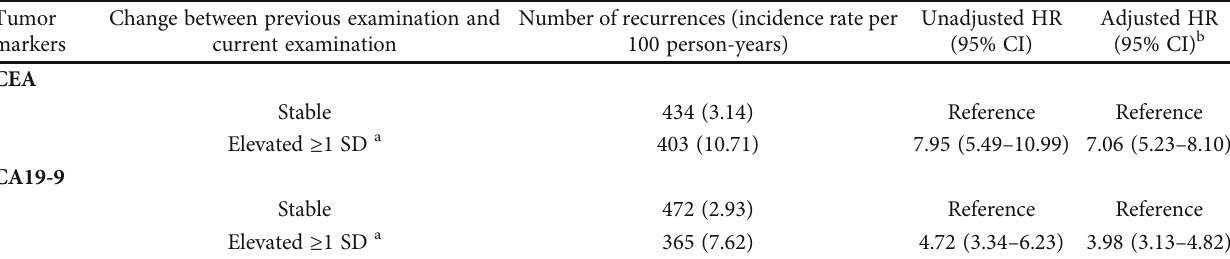
Table 2: HR for recurrence based on changes in CEA and CA